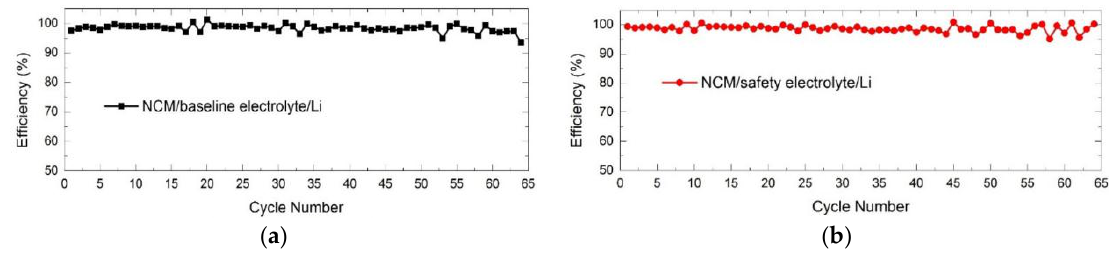
Figure 3. Cycle efficiency of half cells. The half cells were cycled between 2.0 V and 4.2 V at 0.1C: ( a ) NCM/baseline electrolyte/Li half cells; ( b ) NCM/safety electrolyte/Li half cells.